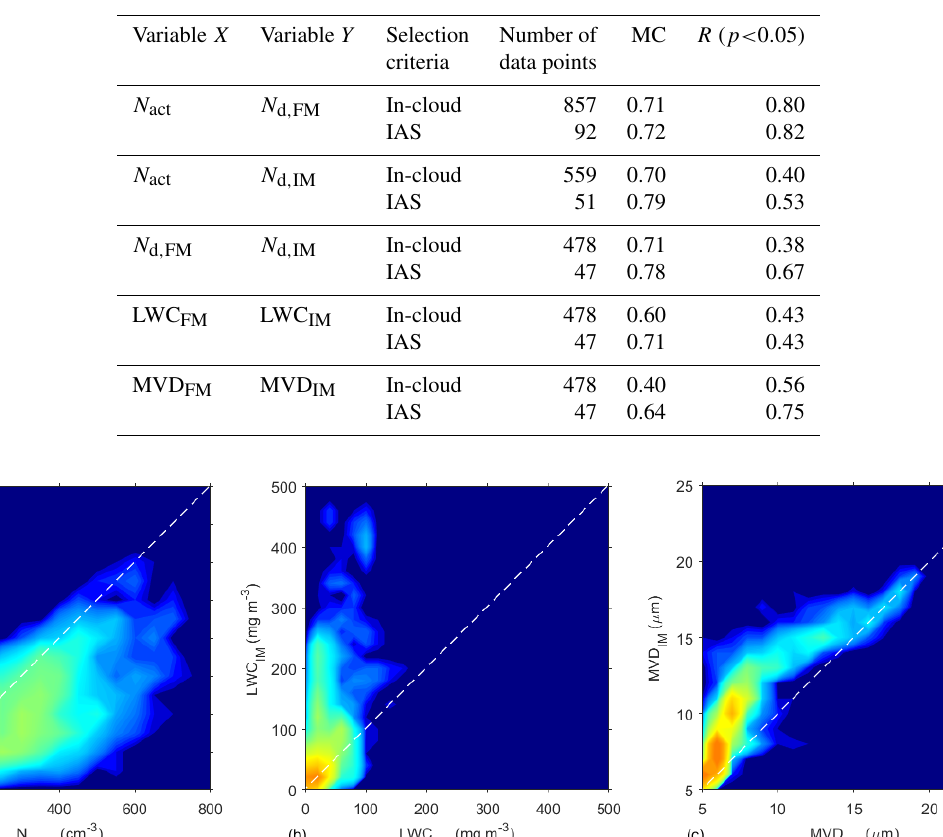
Table 2. Pearson correlation coefficients ( R ) and mutual correlations (MC) between measured variables for the total data set (In-cloud) and isoaxial sampling (In-cloud IAS, θ ± 30 ◦ ).